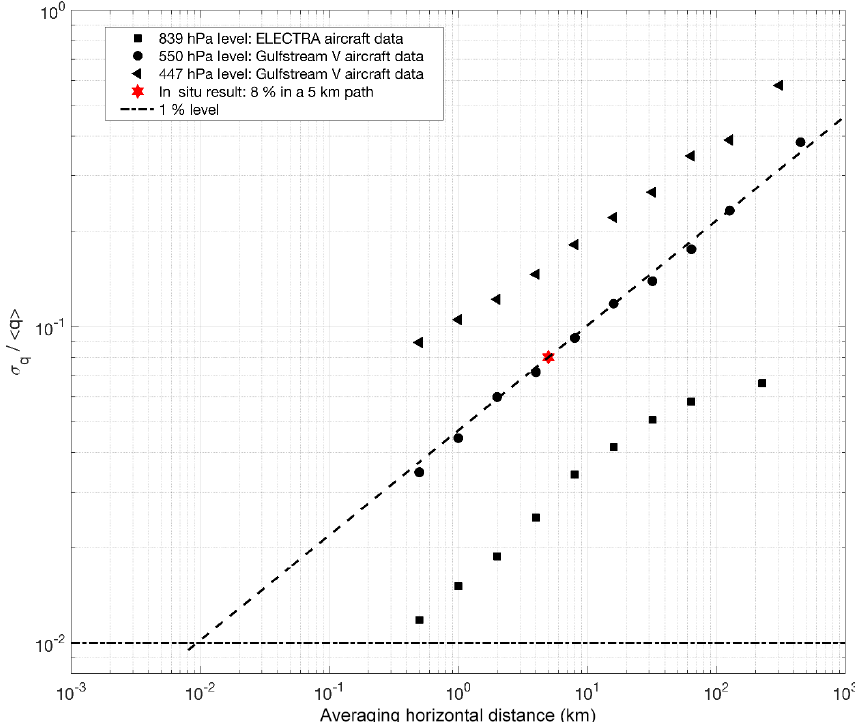
Figure Appendix A1. Ratio of the standard deviation of absolute humidity to the mean absolute humidity based on aircraft data taken at different altitudes, which is indicated by the air pressure along different flight paths. The red star on the dashed line constructed for the 550hPa altitude observations corresponds with the value calculated from the three in situ sensors operating during the ATOMMS mountaintop experiment (ratio of 8% for a 5km path). The slope of the dashed line corresponds with a power law exponent of 0.35 for the dependence of SD (q)/ mean (q) with the length of the path, which is consistent with Kolomogorov turbulence. Extrapolation of this line to a SD (q)/ mean (q) value equal to 1% indicates that in situ observations are required every 10m in order to validate the 1% accuracy of the ATOMMS retrievals. Adapted from Otarola et al.